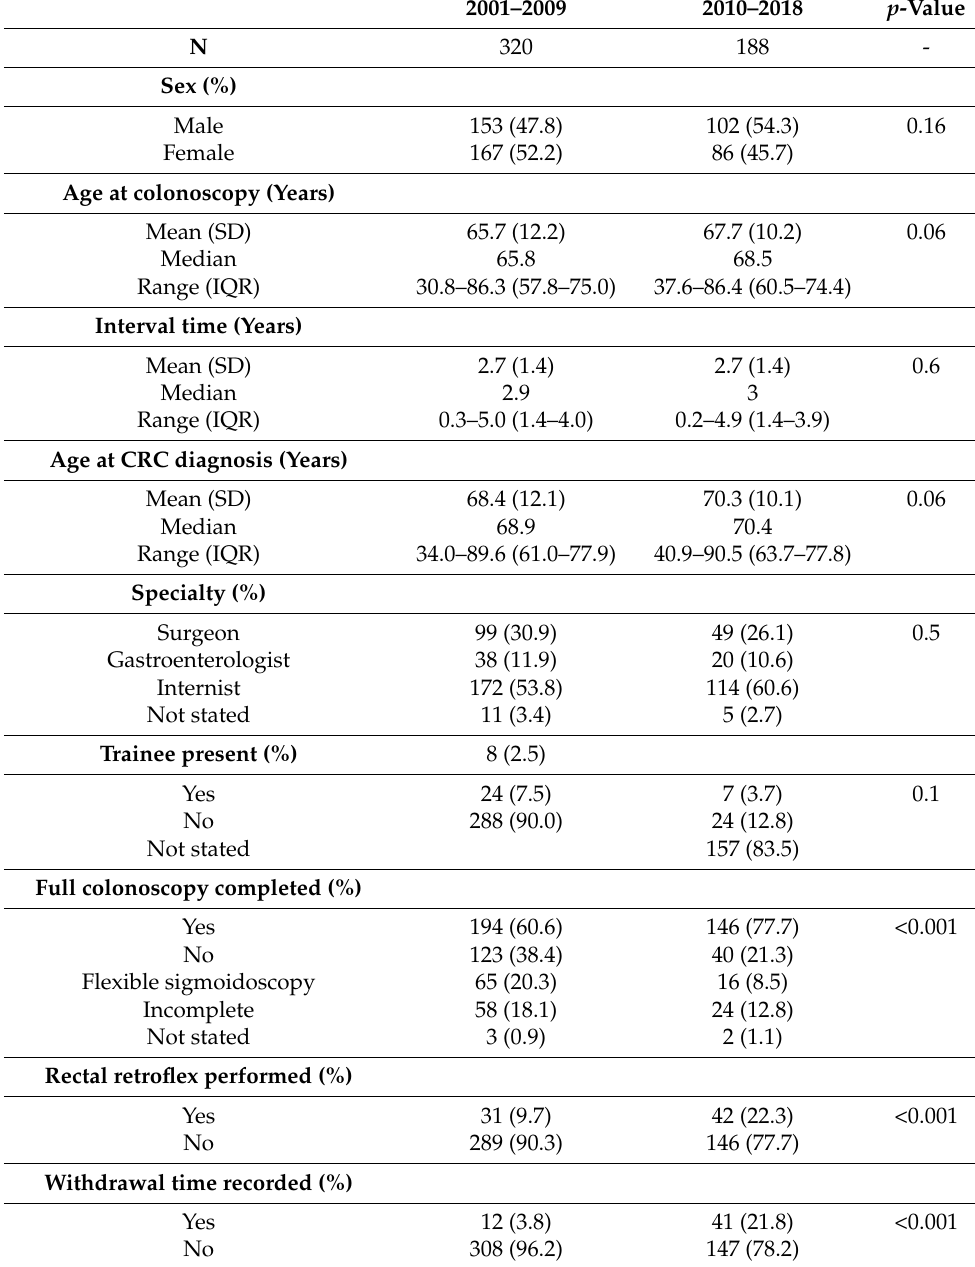
Table 2. Patient, endoscopy, and pathological characteristics of analyzed charts dichotomized by time